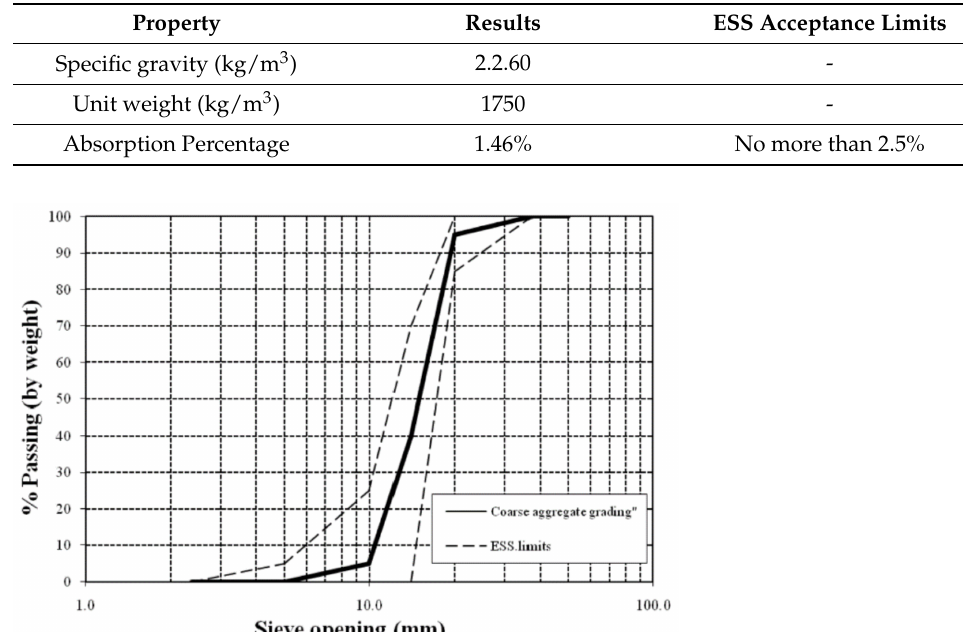
Table 2. The physical and mechanical properties of the coarse aggregate.